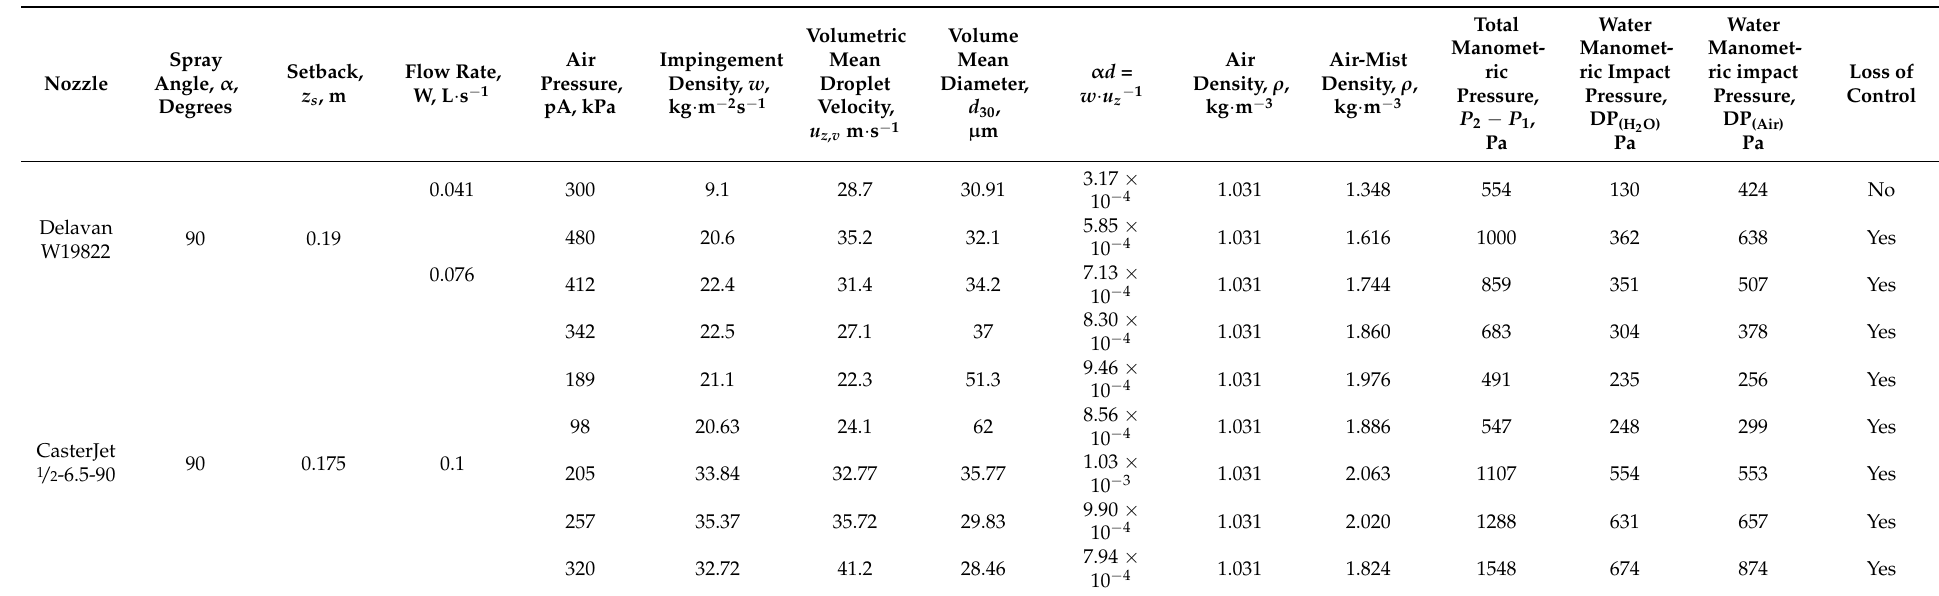
Table 2. Effect of air-mist characteristics on loss of control and shutdown when using soft